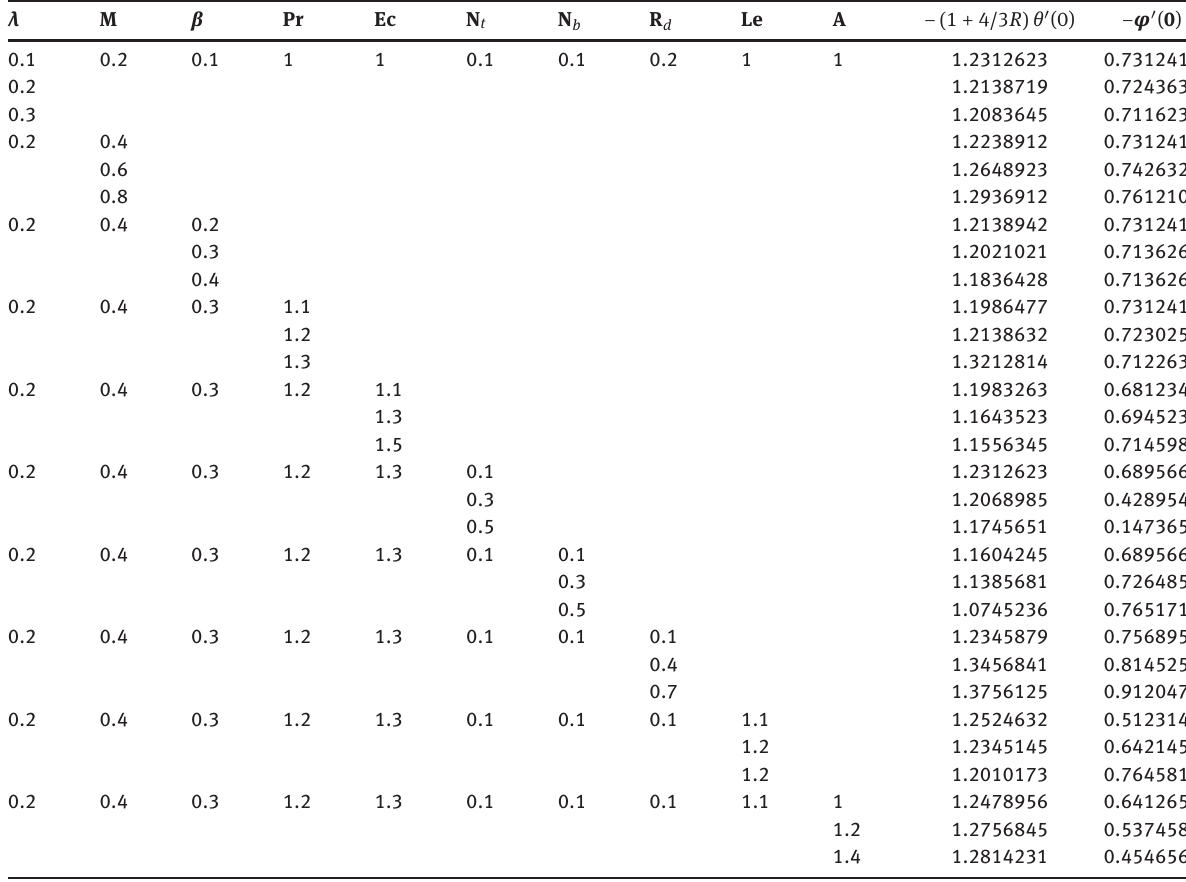
Table 4: Numerical values of the local Nusselt number − θ (cid:3) (0) and the Sherwood number − φ (cid:3) (0) for different